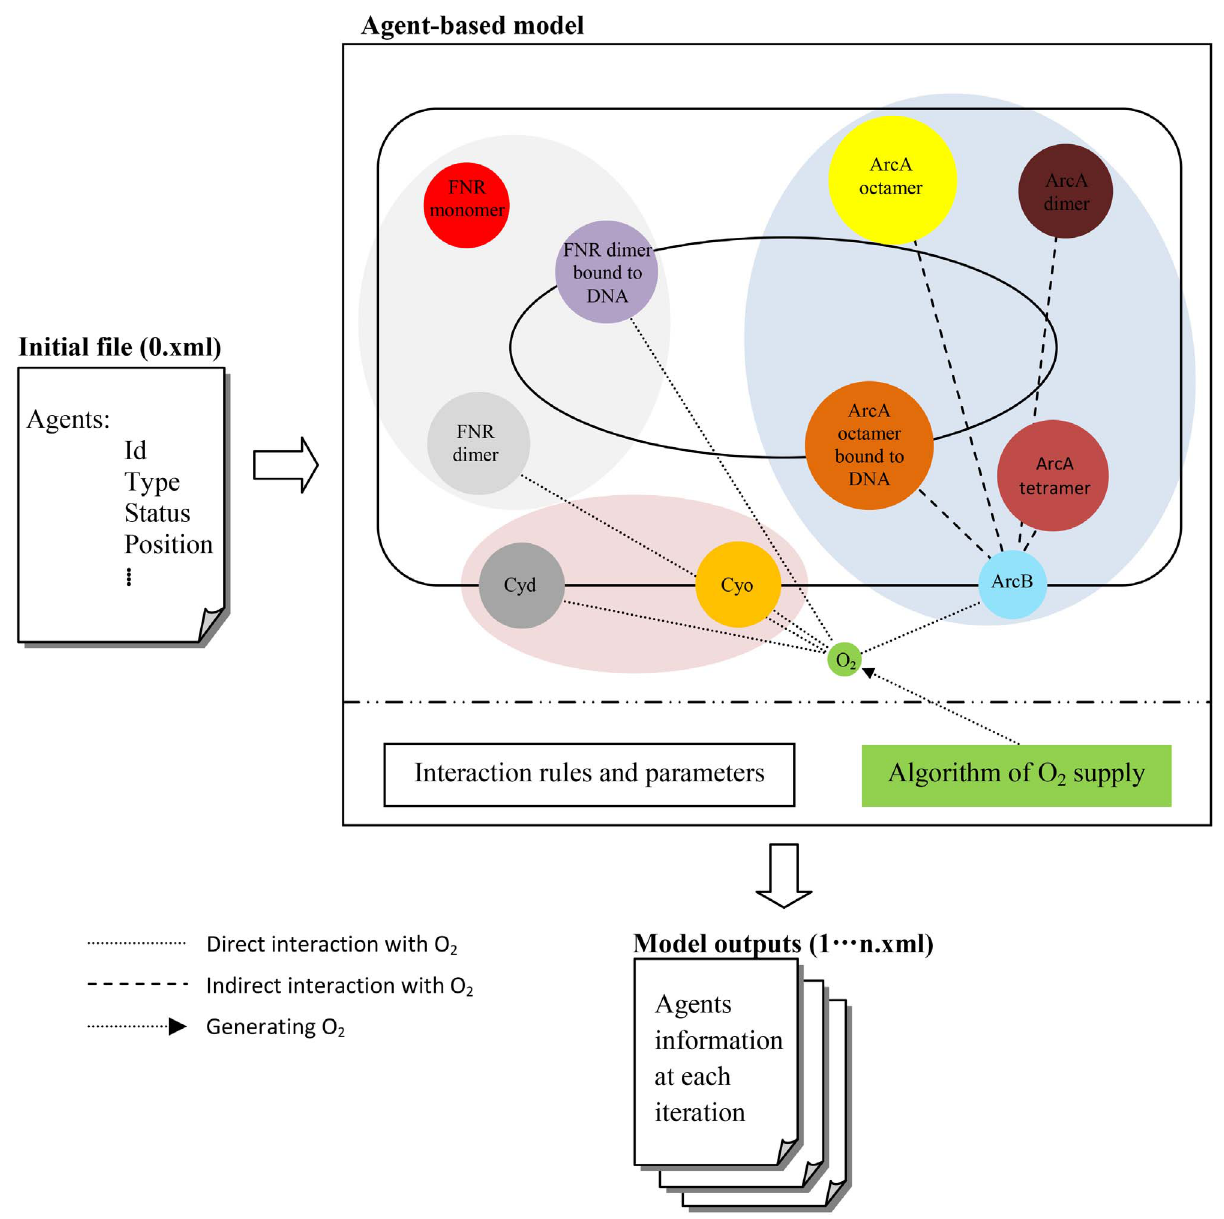
Figure 2. Components and process of agent-based model simulation. The file 0.xml contains all the settings for the agents involved to provide the initial model state. The FNR system, ArcBA system and terminal oxidases are displayed in light grey, light blue and light red ellipses respectively. The interaction rules and parameters are pre-defined, which determines how and when the interactions take place. For each of the iterations the number of O 2 molecules supplied to modelled cell is calculated. While model runs, updated information is generated in the same format as the initial file and stored in a series of xml files for further analysis. Experimental data, where available, were used for preparing the initial file and designing the interaction rules and